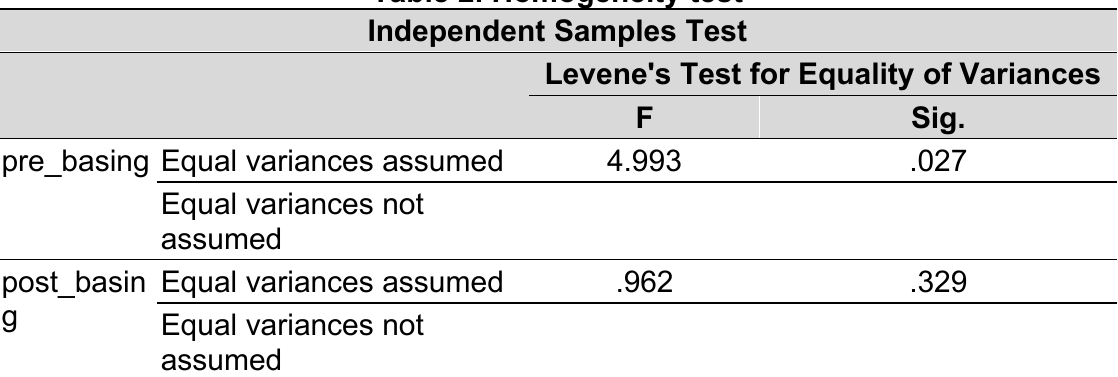
Table 2. Homogeneity